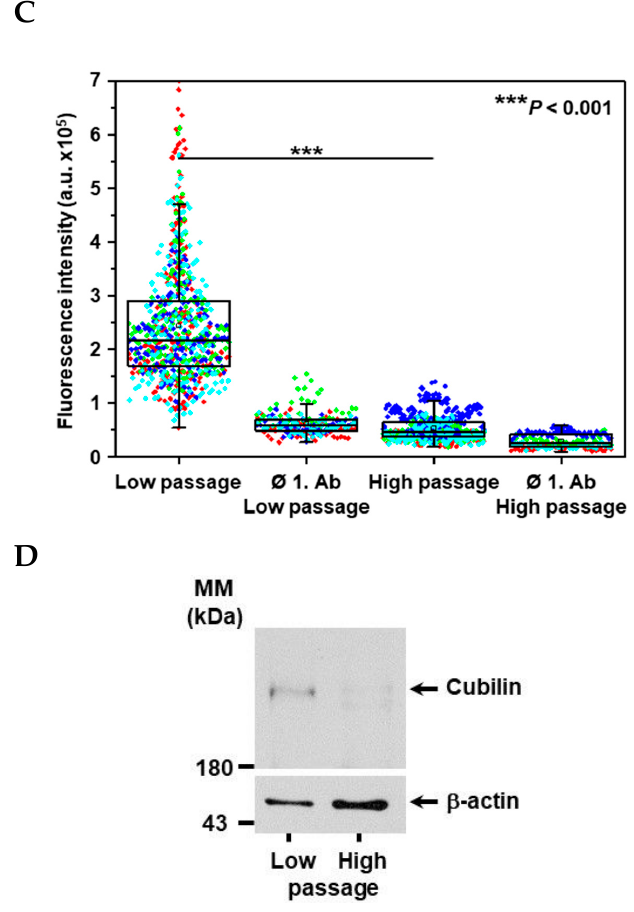
Figure 1. Expression of megalin and cubilin in cultured low and high passage rat renal proximal tubule cells (WKPT-0293 Cl.2). ( A ) Expression levels of megalin ( Lrp2 ) and cubilin ( Cubn ) mRNA by qPCR in means ± SD of 4 experiments are shown. The C T values in low passage cells were 20.6 ± 0.6 and 29.6 ± 0.1 for megalin and cubilin, respectively. Data obtained were normalized to the expression of the reference gene glyceraldehyde-3-phosphate dehydrogenase ( Gapdh ). Statistical analysis compares the low and high passage cells by unpaired t -test. ( B ) Expression of megalin protein in low and high passage WKPT-0293 Cl.2 cells. Megalin was detected by immunofluorescence microscopy of permeabilized cells (green). Nuclei were counterstained with Hoechst 33342 (blue). The experiment is representative of four similar ones. Scale bar = 20 µm. ( C ) Fluorescence intensity was analyzed in 188–705 cells (dots) from 4 different experiments (colors); for details of box and whisker plot statistics, see Section 4. Statistical analysis compares the low and high passage cells by non-parametric one-way ANOVA (Kruskal-Wallis-Test, using Dunn’s post-hoc analysis). ( D ) Expression of cubilin protein was detected by immunoblotting. β -actin was used as loading control. A representative experiment is shown. MM = molecular mass.